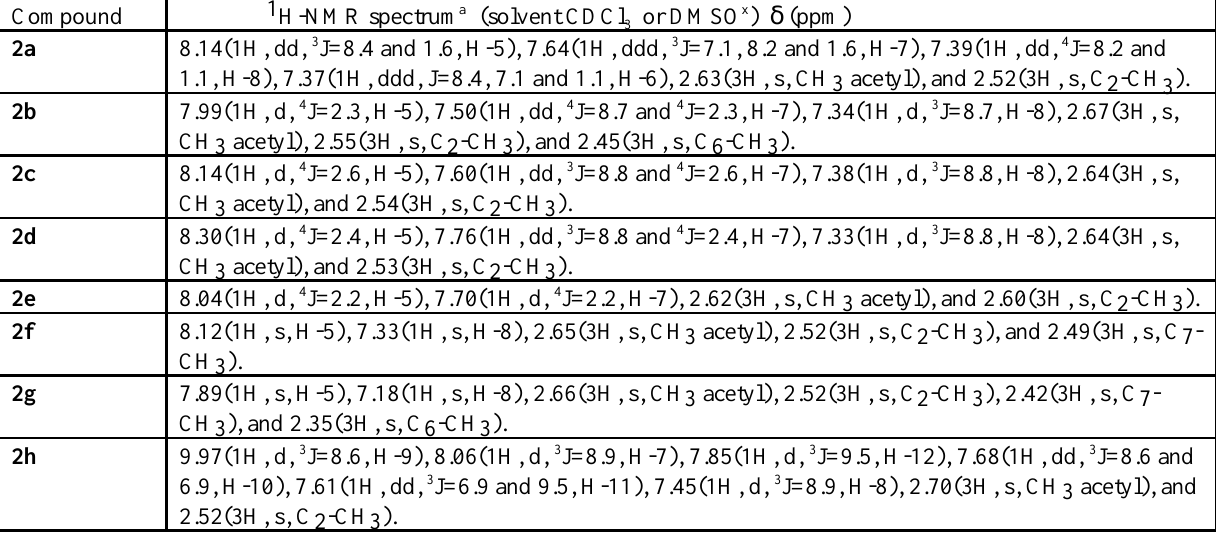
Table 2. 1H-NMR spectra of the prepared compounds.